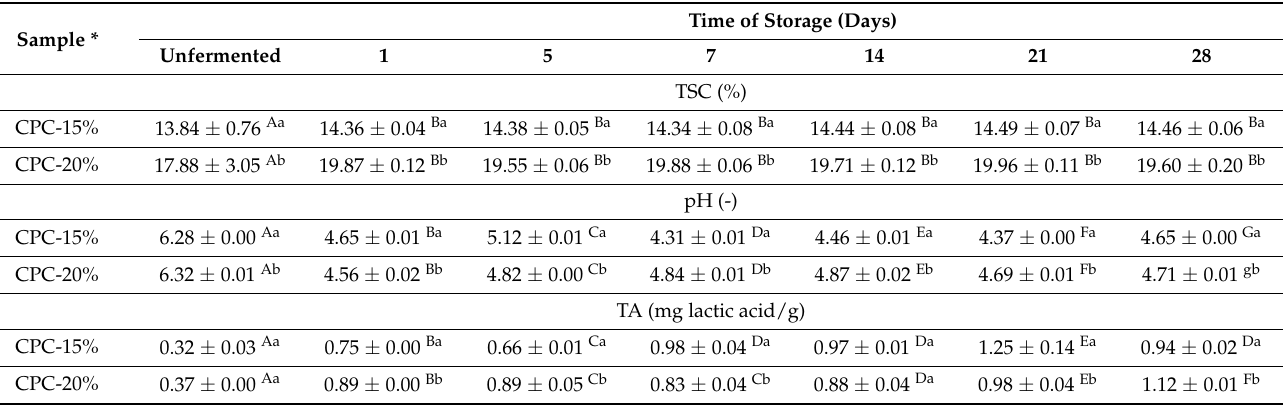
Table 1. The Total Solids Content (TSC), pH and Titratable Acidy (TA) of fermented beverages and unfermented (control)